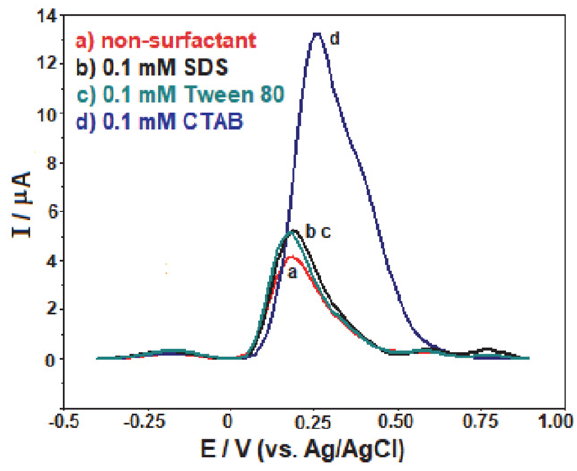
Figure 5. The SW voltammograms of 0.1 mM lawsone solutions in phosphate buffer (pH 2.5) at the different surfactants’ media on APT-BDD electrode. SWV parameters: frequency, 50 Hz; step po- tential, 8 mV; pulse amplitude, 30